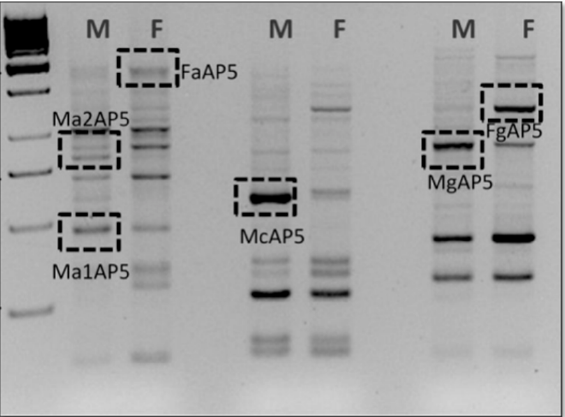
Figure 2. Representative gel image of DDRT-PCR band pattern. The image shows amplifications of cDNA from gonad embryos performed using a 5’ arbitrary primer (H-AP5) in combination with 3’ oligo (dT) H-T11A primer on male (Ma) and female (Fa) embryos. Table 3. Sequence analysis of differentially expressed mRNAs isolated by DDRT-PCR.